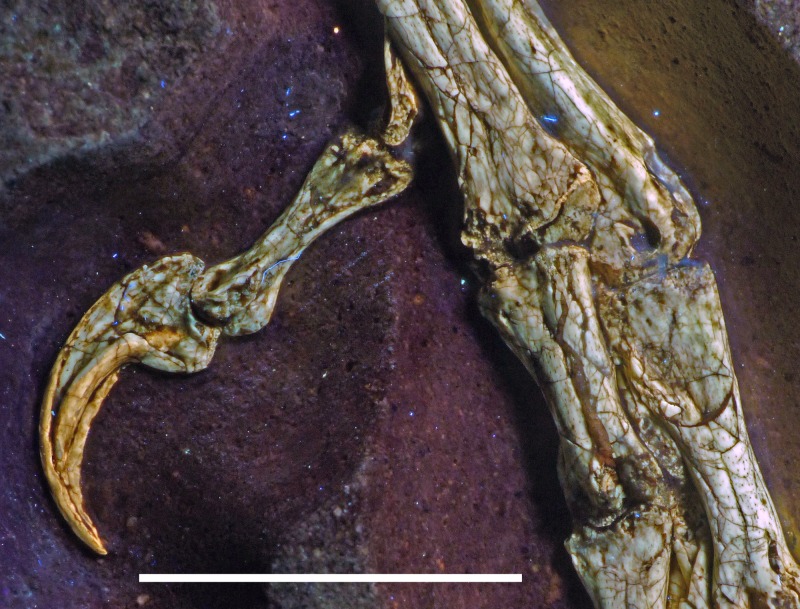
Digit I of the pes of the 12th specimen of Archaeopteryx.Photograph of the right digit I under UV light, showing the twist in phalanx I-1 and the horny sheath of the ungual. Scale bar is 10 mm.